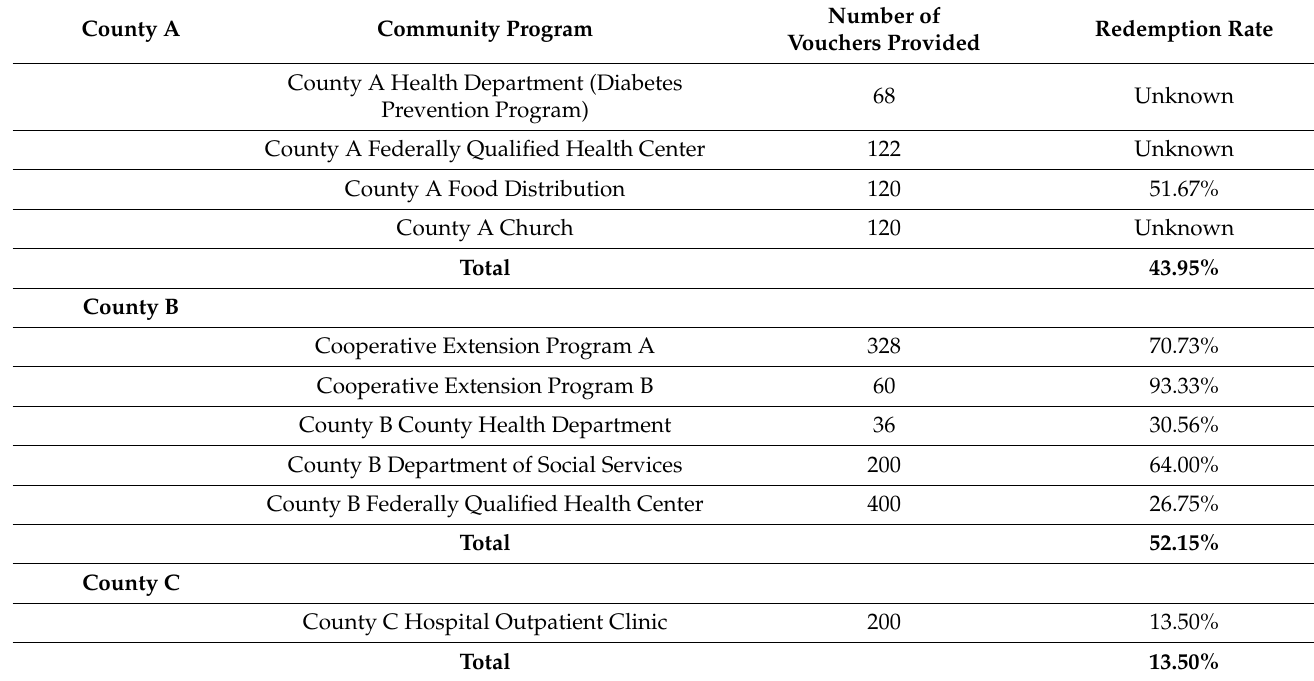
Table 1. Redemption rates for the PICH Produce Prescription Program in nine northeastern North Carolina Counties. Total redemption rates for each county are in bold